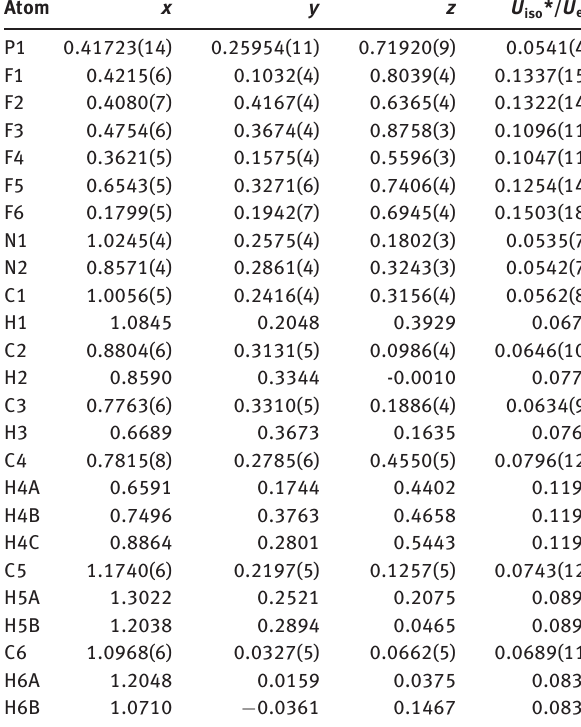
Table 2: Fractional atomic coordinates and isotropic or equivalent isotropic displacement parameters (Å 2